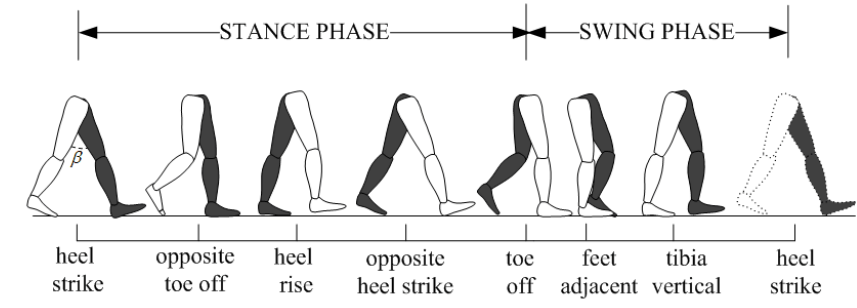
Figure 9. Typical normal gait